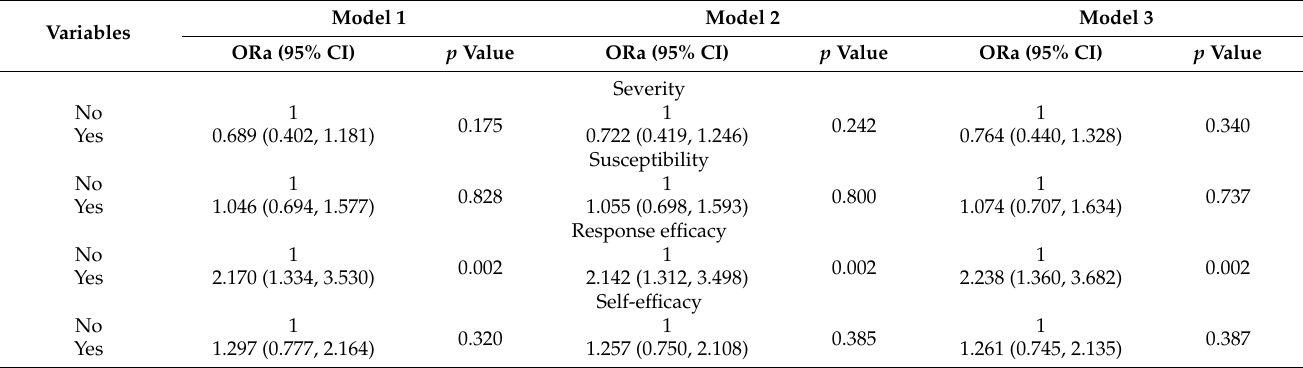
Table 5. Results of multivariate logistic regression model adjusted with covariates ( n = 1602) a